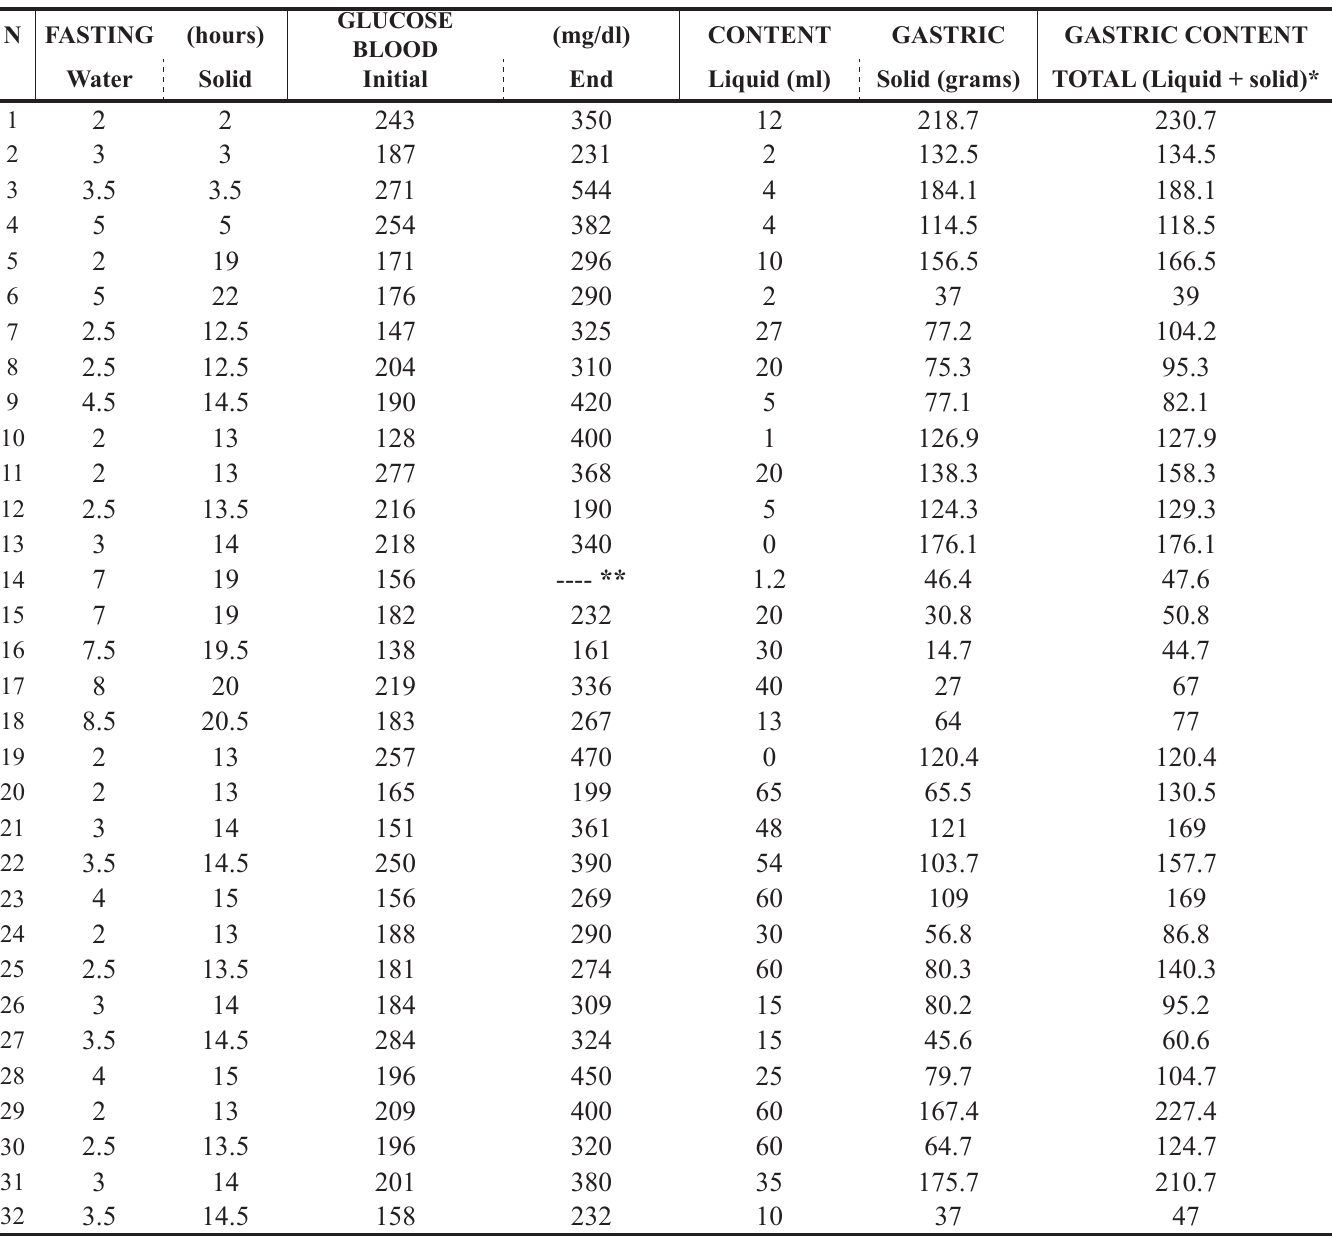
TABLE 1 - Distribution of rabbits in accordance to the fasting time, initial and end glucose blood value, quantity of liquid, solid and total gastric